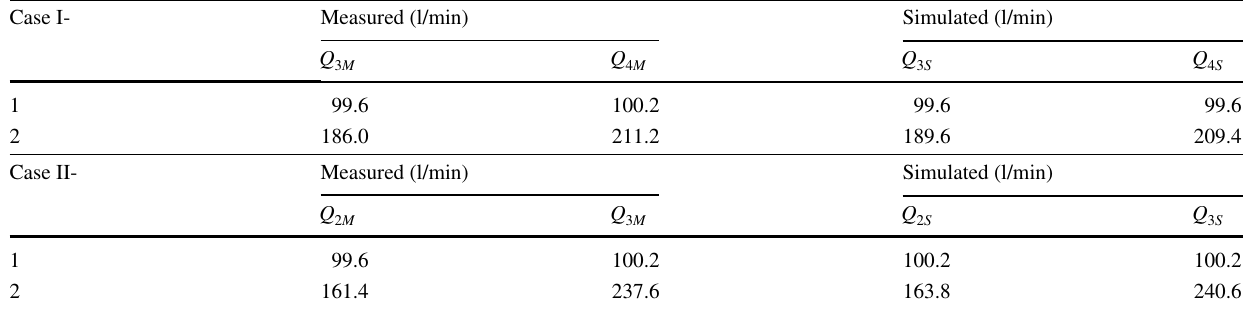
Table 3 Comparison of outflows measured and simulated at two downstream channels boundaries Case